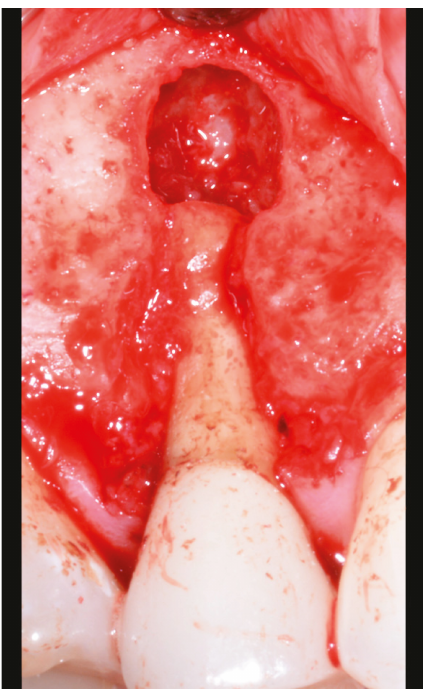
Figure 7: Apical resection of premolar root showing vertical bone resorption at the cortical vestibular